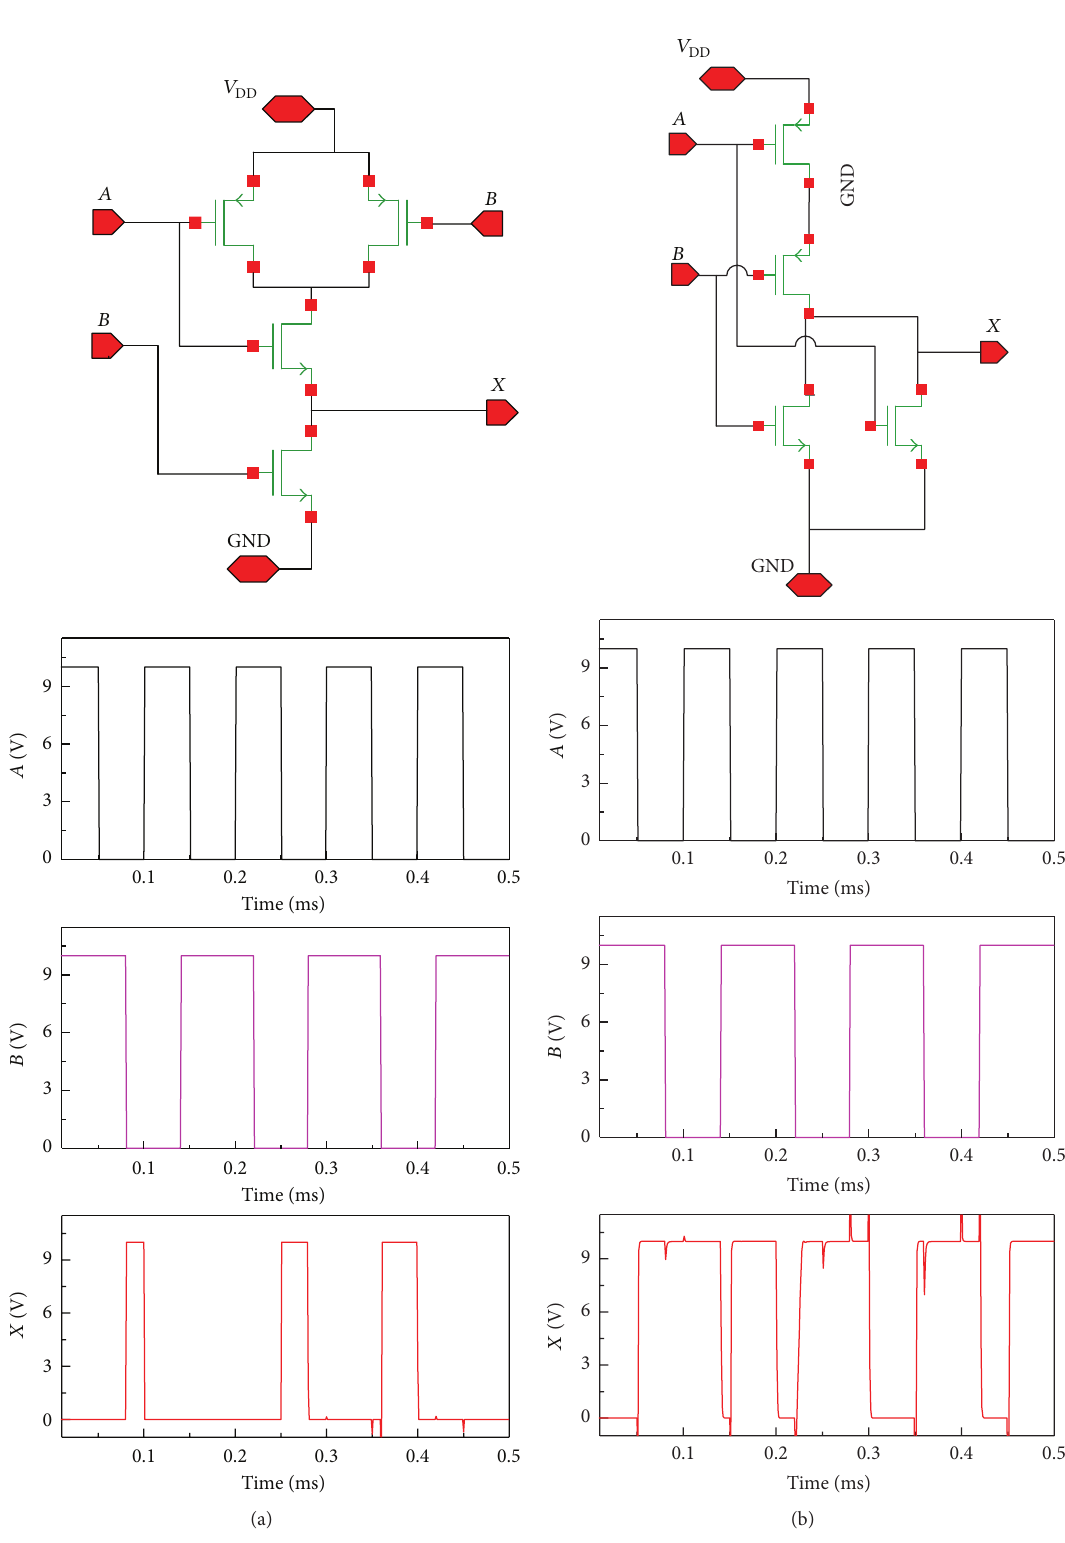
Figure 6: Schematics (top) and waveforms (bottom) of (a) NOR and (b)